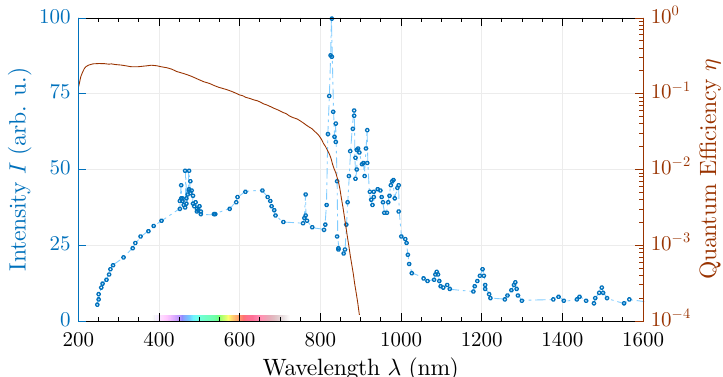
Figure 10. Spectral output of the xenon arc lamp based on [94,95] (left scale, blue dots) and quantum efficiencies of the photomultiplier tube (PMT) from [94,96] (right scale, brown solid line) used in present studies.